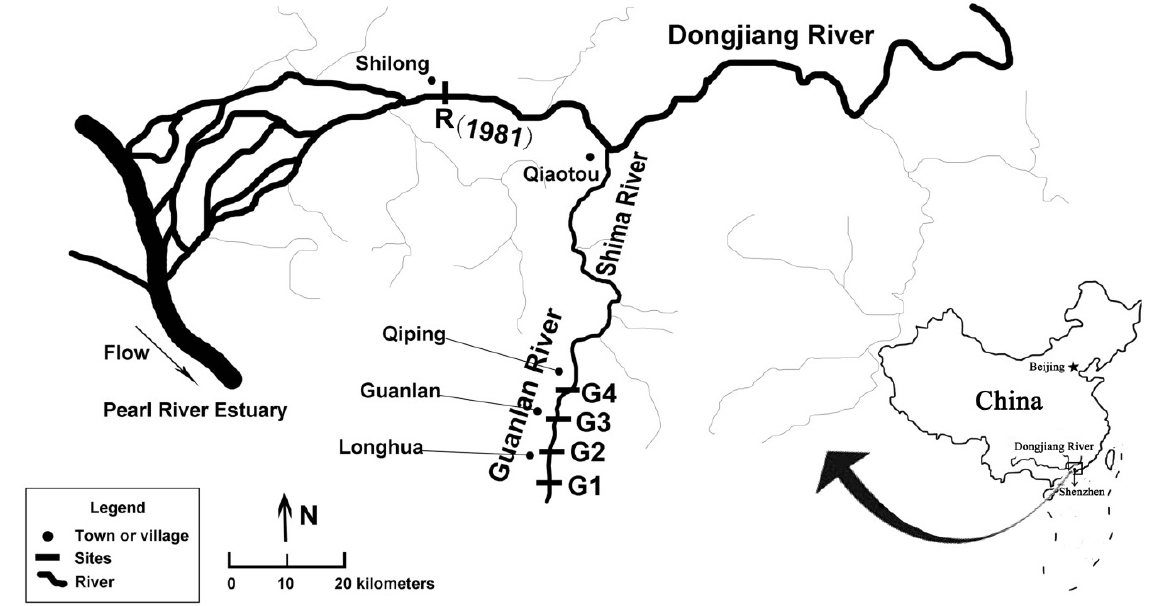
Figure 1. Study area and sampling sites. R was the sampling site (Shilong site) in 1981.